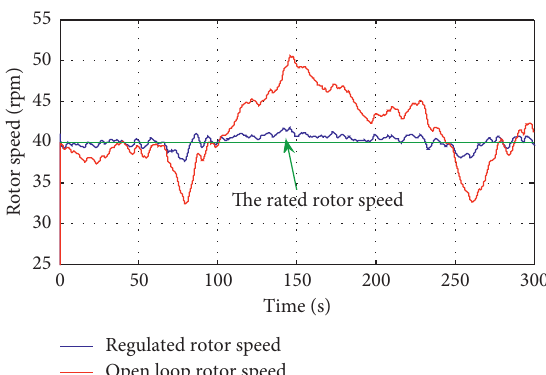
Figure 9: Rotor speed